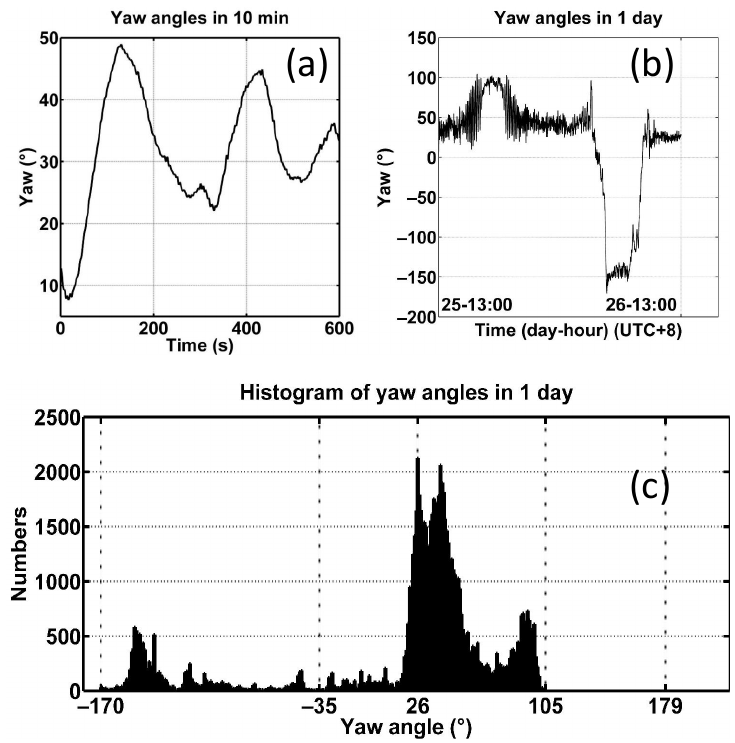
Figure 5. Yaw angles: ( a ) first 10 min (time span 1 s); ( b ) 1 day (time span 1 s); ( c ) histogram of yaw angles in 1